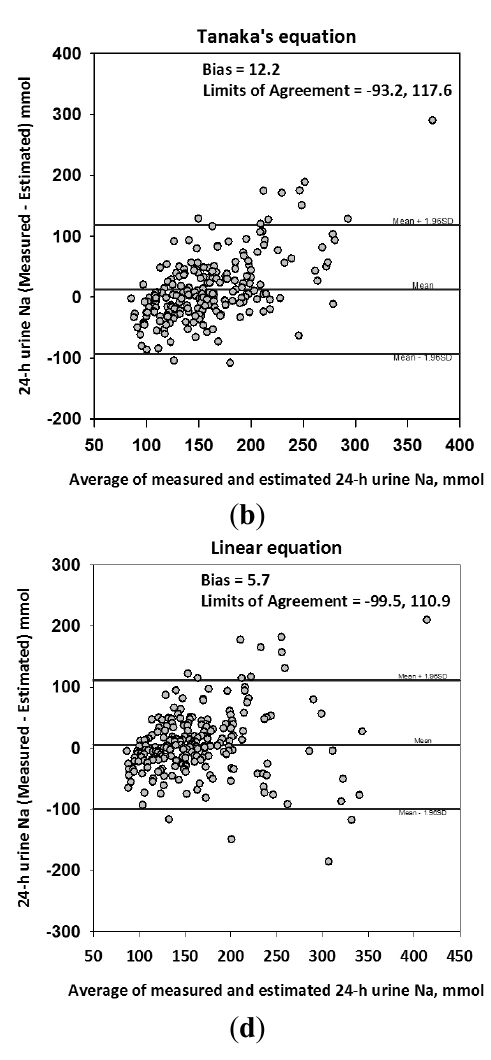
Figure 4. Bland-Altman analysis for agreement of the six equations. ( a ) Kawasaki’s equation; ( b ) Tanaka’s equation; ( c ) INTERSALT equation; ( d ) linear equation; ( e ) quadratic equation; ( f ) cubic